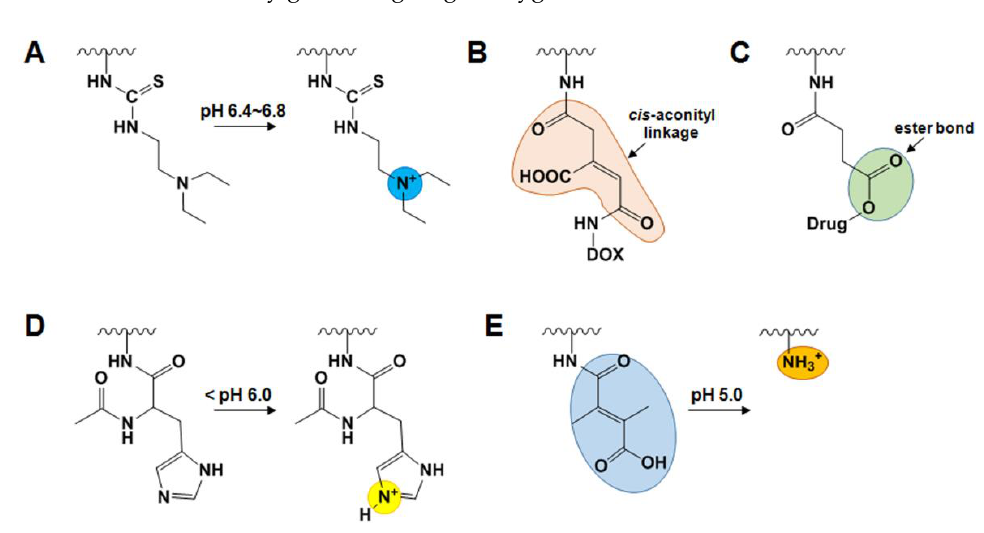
Figure 3. pH sensitive GC derivatives. ( A ) Self-assembled GC-DEAP in neutral pH drastically underwent conformational changes at acidic extracellular pH via the dissociation after protonation of DEAP moiety in GC. ( B , C ) Polymer-drug conjugates which were linked through cis -aconityl linkage or ester linkage were cleaved at acidic intracellular pH environment, leading to release of drugs into the cytosol. ( D ) Under endosomal pH (below pH 6.0), the imidazole group of NAcHis in NAcHis-GC derivatives were protonated to destabilize the self-assembled nanostructures of NAcHis-GC. ( E ) DMA (2,3-dimethylmaleic anhydride) moiety conjugated to GC was stable at neutral pH. Once it is exposed to acidic endosomal pH 5.0, the amides between GC and DMA were hydrolyzed to regenerate the positively charged amine group.